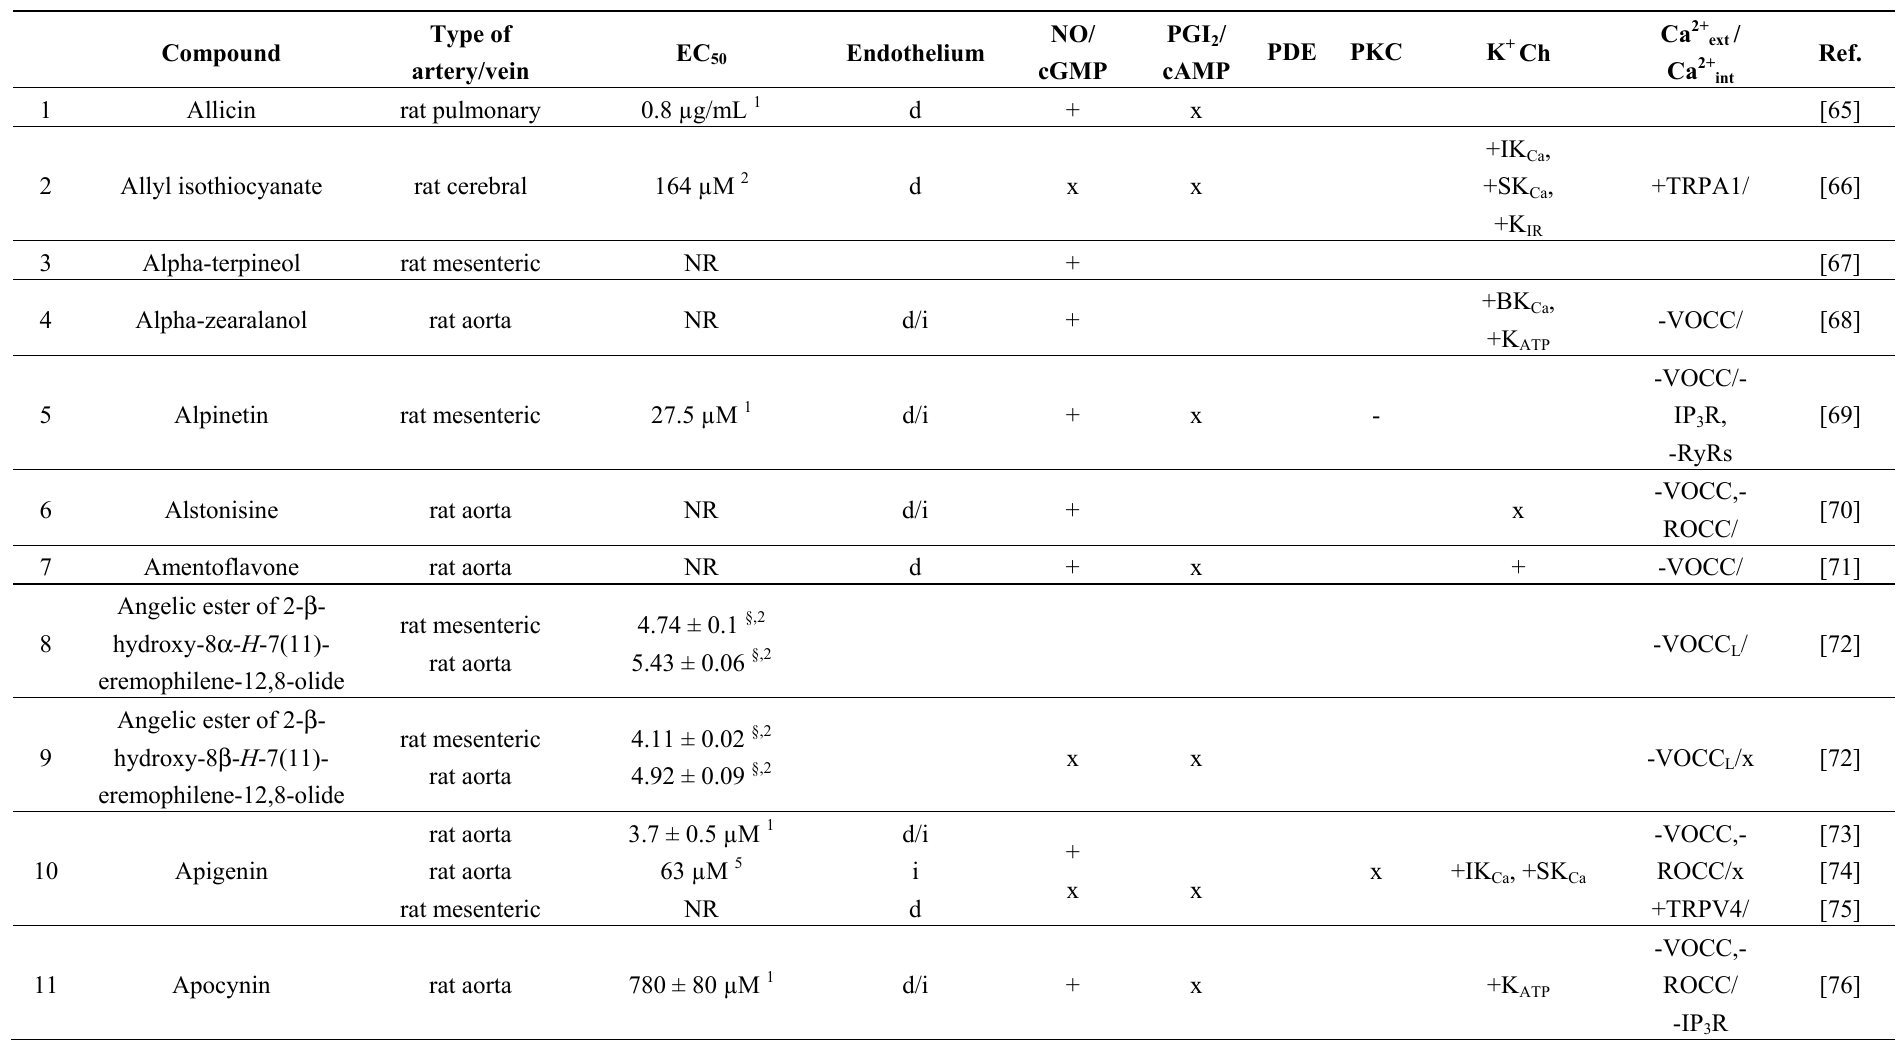
Table 1. Mechanisms of action proposed for vasodilator compounds obtained from